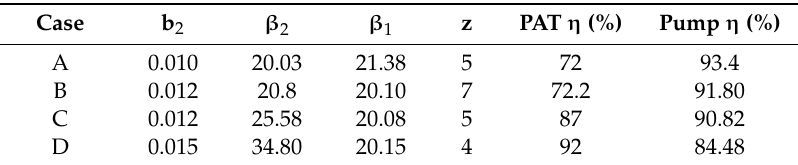
Table 9. Variables for optimal cases.